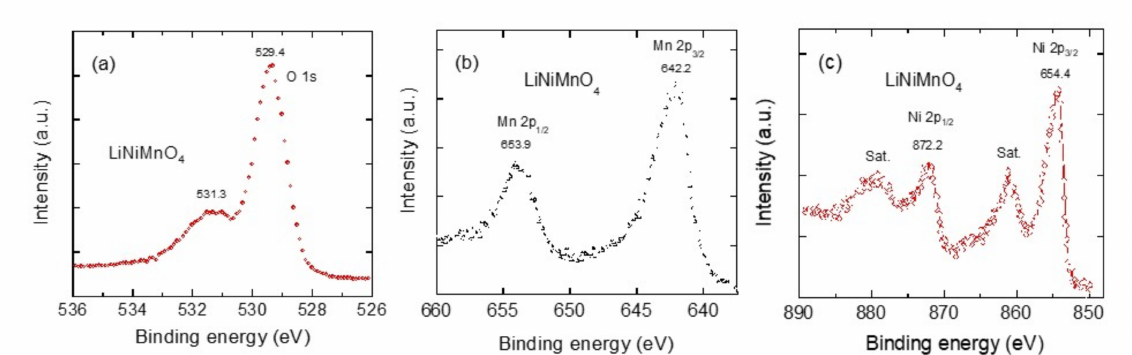
Figure 6. XPS analysis of LiNiMnO 4 spinel powder synthesized by sol-gel method. ( a ) XPS spectrum of the O 1s region. ( b ) XPS spectrum of the Mn 2p region. ( c ) XPS spectrum of the Ni 2p region. Satellite peaks are marked by